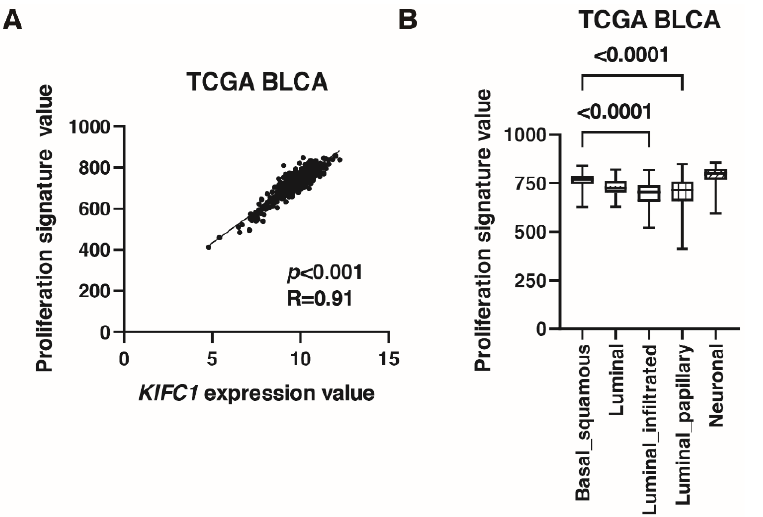
Figure 4. KIFC1 is associated with proliferation in bladder cancer (BC). ( A ) The correlation between KIFC1 expression and proliferation signature value in TCGA BLCA. Spearman’s correlation coefficients and p -values are indicated. ( B ) Box plot of proliferation signature value by molecular classification in TCGA BLCA.